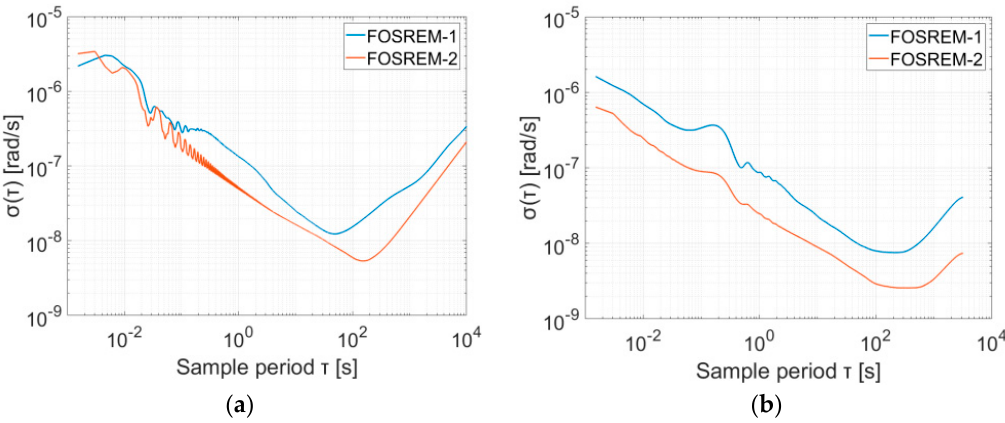
6 of 11 Table 1. The parameters of Angle Random Walk (ARW) and Bias Instability (BI) for FOSREM-1, -2 determined from the data gathered in various positions of FOSREMs.